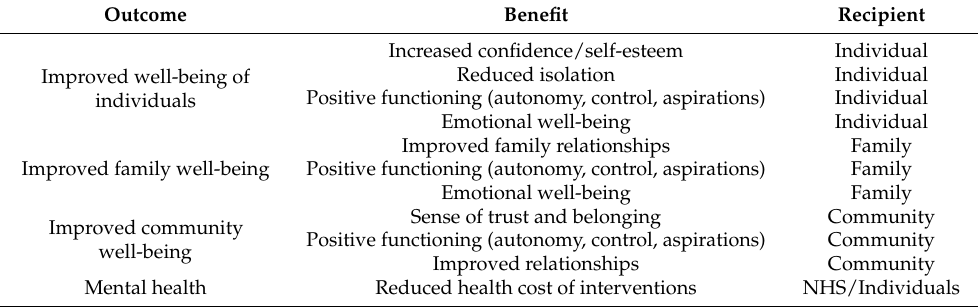
Table 6. Domains of target outcome, benefit and recipient as per